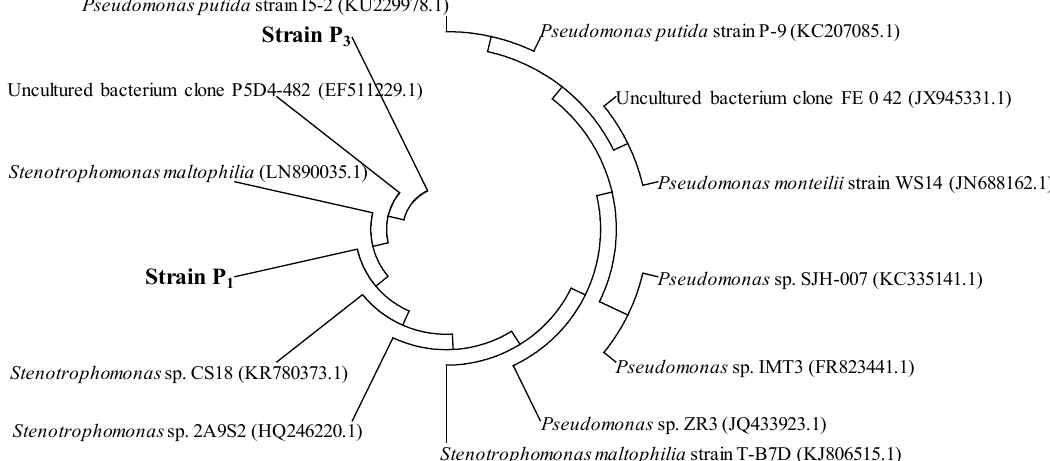
Figure 2. Phylogenetic analysis of isolated strains P 1 and P 3 based on 16S rRNA gene homology.